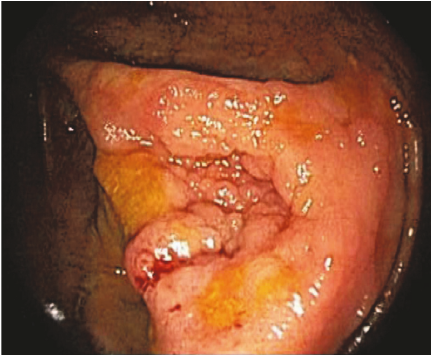
Figure 36: Endoscopic image of a large cecal polyp involving the appendiceal orifice and almost the entire cecal